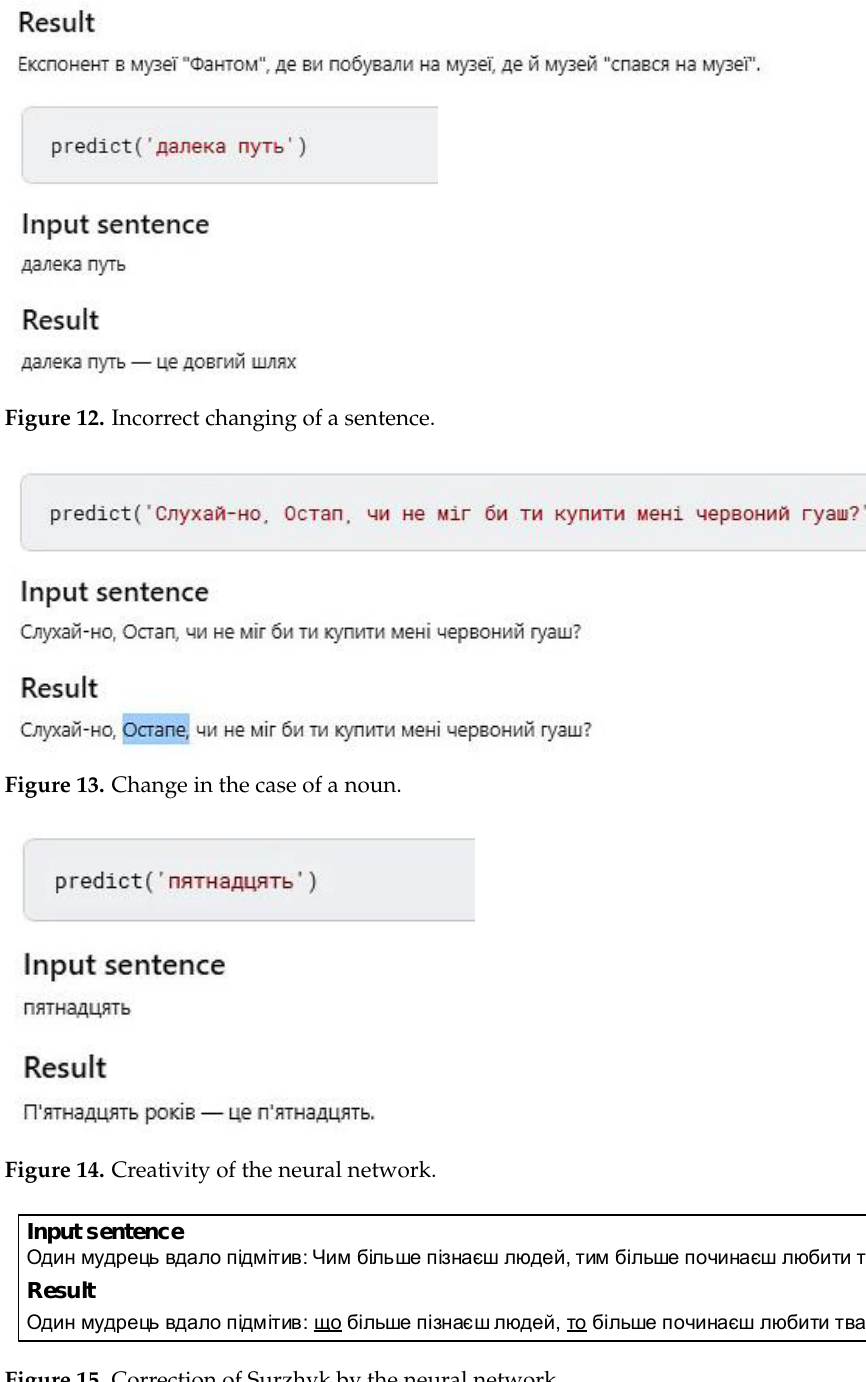
Figure 12. Incorrect changing of a sentence.